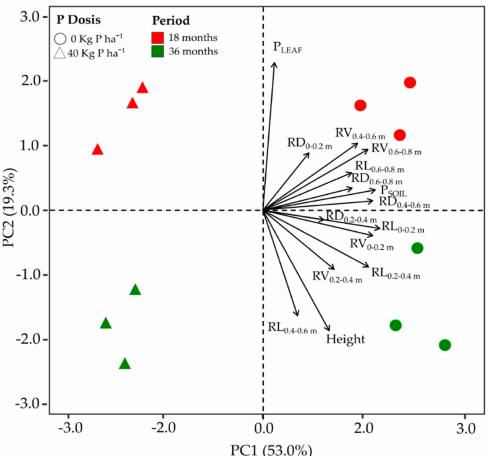
Figure 8. Correlation between principal components 1 (PC1) and 2 (PC2) in root morphological variables, P concentration in soil and leaves, and height of H. heptaphyllus plants subjected to application of different P rate in the soil and evaluated at different times, where P LEAF : phosphorus concentration in leaves; P SOIL : phosphorus content in the soil; RD 0–0.2 m : total living root volume (mm 3 tube − 1 ) in 0–0.2 m soil layers; RD 0.2–0.4 m : total living root volume (mm 3 tube − 1 ) in 0.2–0.4 soil layers; RD 0.4–0.6 m : total living root volume (mm 3 tube − 1 ) in 0.4–0.6 soil layers; RD 0.6–0.8 m : total living root volume (mm 3 tube − 1 ) in 0.6–0.8 m soil layers; RL 0–0.2 m : total length of living roots (mm) in 0–0.2 m soil layers; RL 0.2–04 m : total length of living roots (mm) in 0.2–0.4 soil layers; RL 0.4–0.6 m : total length of living roots (mm) in 0.4–0.6 soil layers; RL 0.6–0.8 m :total length of living roots (mm) in 0.6–0.8 m soil layers; RV 0–0.2 m : total living root volume (mm 3 tube − 1 ) in 0–0.2 m soil layer; RV 0.2–04 m : total living root volume (mm 3 tube − 1 ) in 0.2–0.4 m soil layer; RV 0.4–0.6 m : total living root volume (mm 3 tube − 1 ) in 0–0.2 m soil layer; RV 0.6–0.8 m : total living root volume (mm 3 tube − 1 ) in 0–0.2 m soil